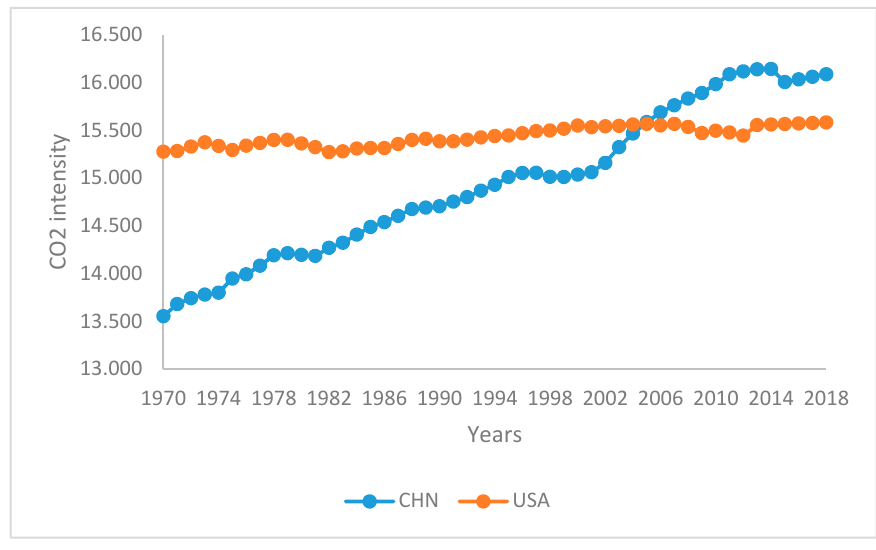
Figure 1. The CO 2 emission intensity of China and the USA.